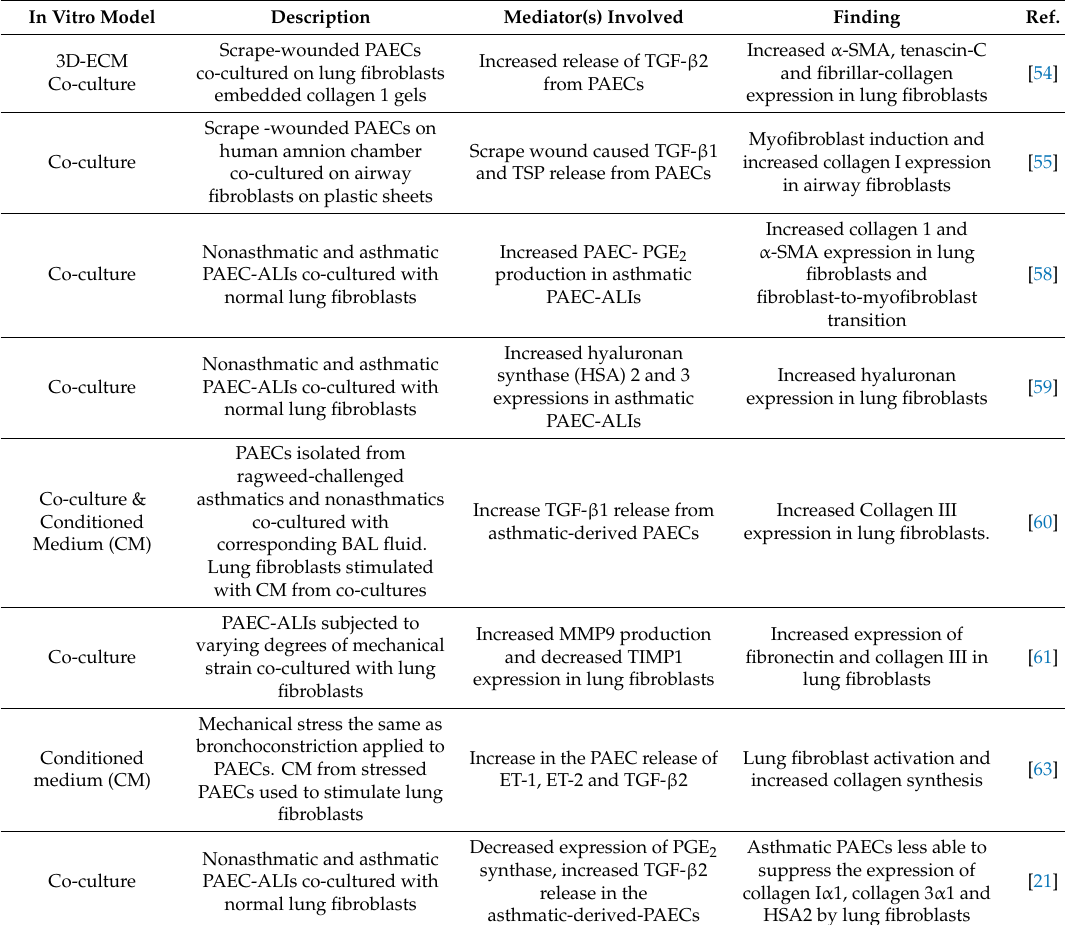
Table 3. Summary of studies assessing ECM homeostasis in asthma with EMTU models. In Vitro